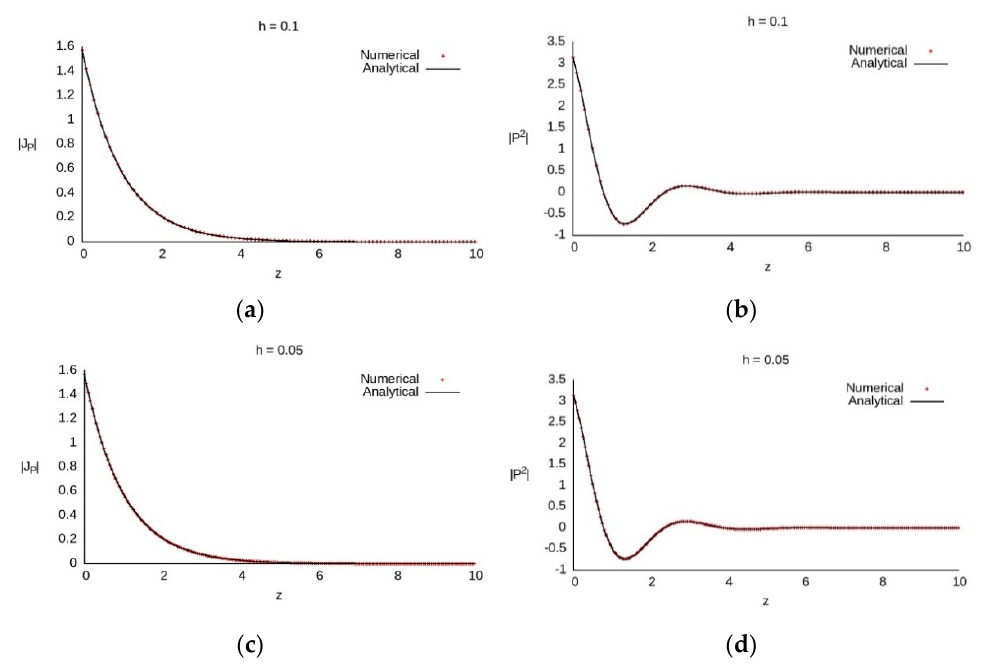
Figure 5. The function P ( z , L t ) (4c) evolution: real part ( a ), imaginary part ( b ), its modulus ( c ), and the pulse’s energy ( d ) obtained via computer simulation (red dotted line) and analytical solution (black solid line) with the parameters D 2 ω = − 0.01, δ 0 = 1, n 0 = 1.